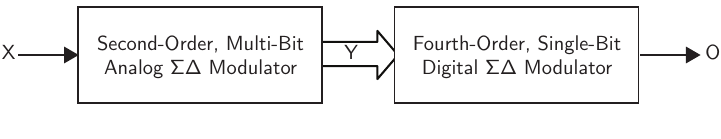
Figure 10. Block diagram of the ΣΔ modulator (example